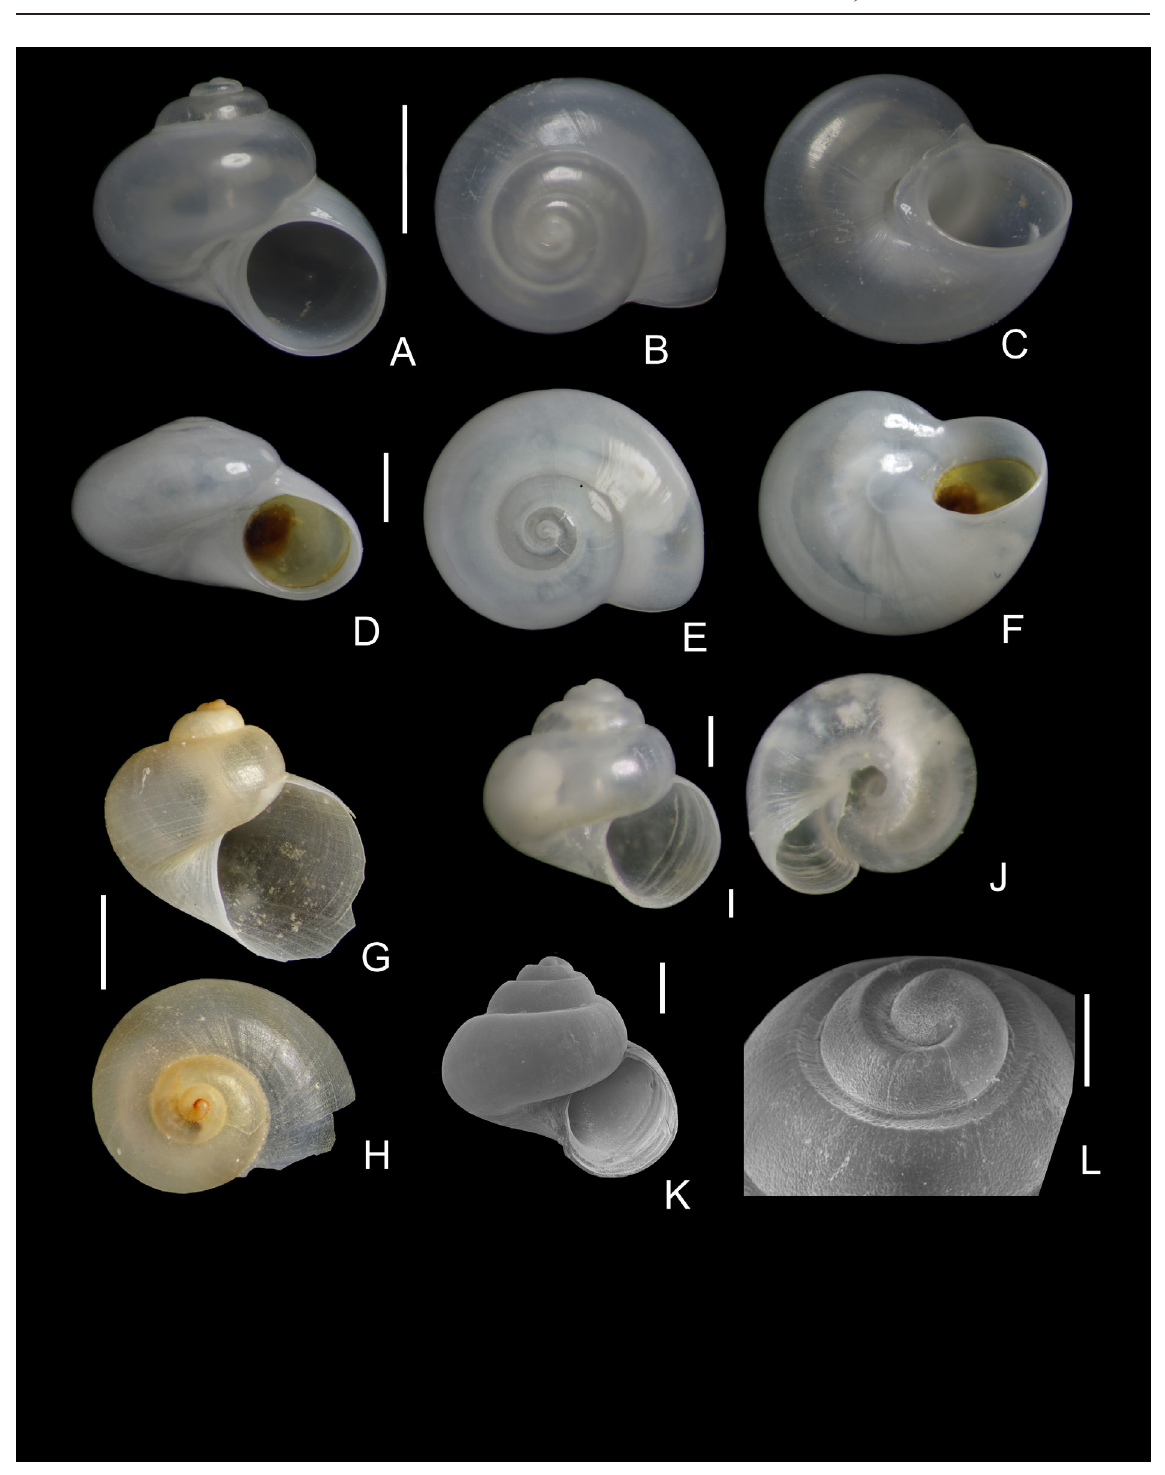
Fig. 14. Skeneimorph species 1. A–C . Cirsonella romettensis (Granata-Grillo, 1877), SEAMOUNT 1, DW116, 985–1000 m, 2.3 mm. D–F . Seamountiella azorica (Dautzenberg & H. Fischer, 1896), SEAMOUNT 1, DW108, 1120–1125 m, 4.2 mm. G–H . Rugulina fragilis (G.O. Sars, 1878), BANGAL 0711, V2, 1706 m, 2.8 mm. I–J . Mikro minimus (Seguenza, 1876), BANGAL 0711, V5, 1631 m, 0.95 mm. K–L . Mikro minimus , SEM micrograph, same shell, and detail of protoconch and apical whorls. Scale bars: A–K = 1 mm: L = 100